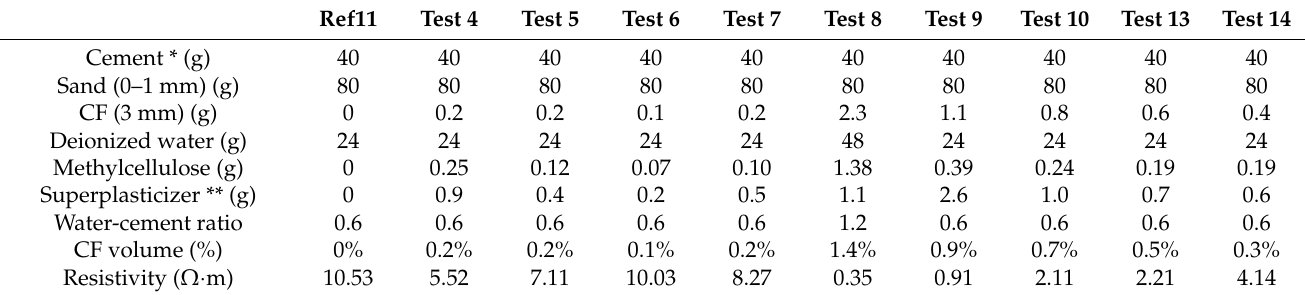
Table 5. Proportions for the cement-based conductive mortar and their